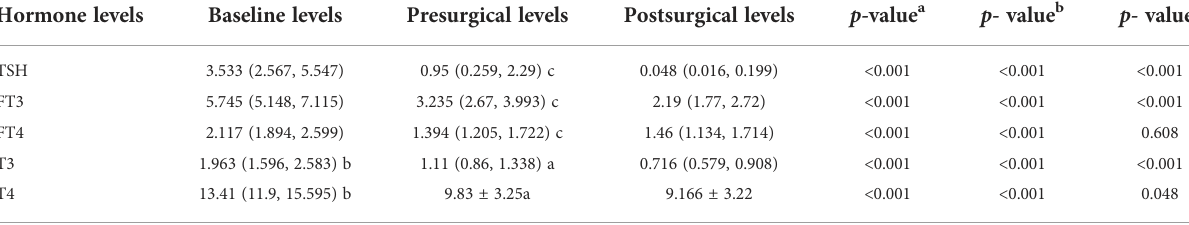
TABLE 4 Thyroid hormone changes during the baseline – medication – surgery process. Hormone levels